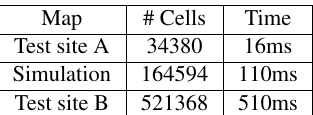
Figure 5. Scheme of a Boustrophedon path computed locally over a horizontal hole taking in consideration the swath width and the desired overlap between the flight lanes Map # Cells